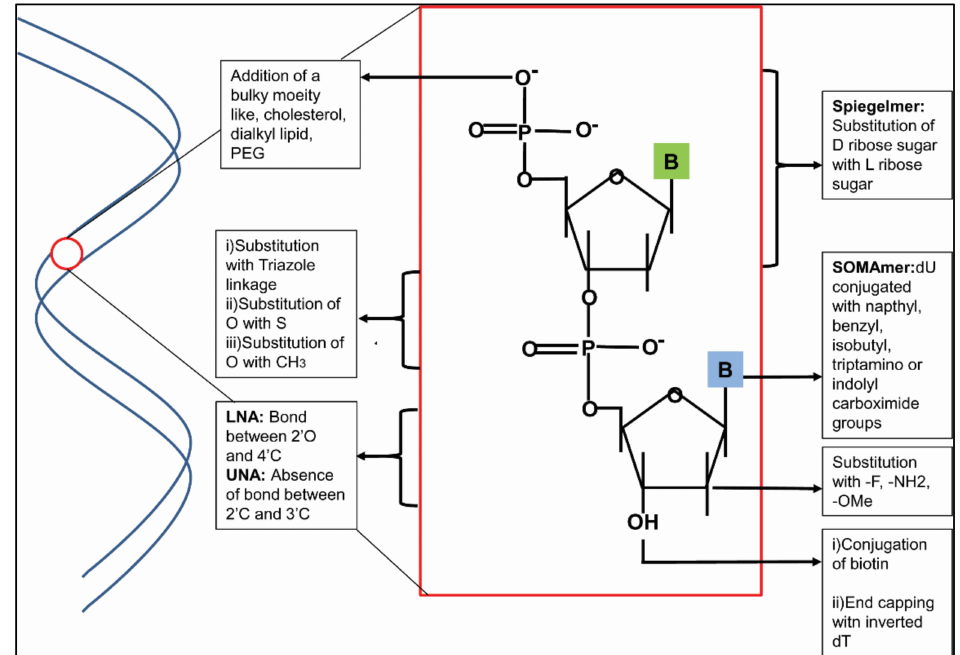
Figure 4. Schematic representation of different modifications in the aptamer. Modifications can be done at the 5 (cid:48) and 3 (cid:48) ends of the sugar phosphate backbone, by substitution of phosphodiester linkage, by using modified bases or by changing the configuration of